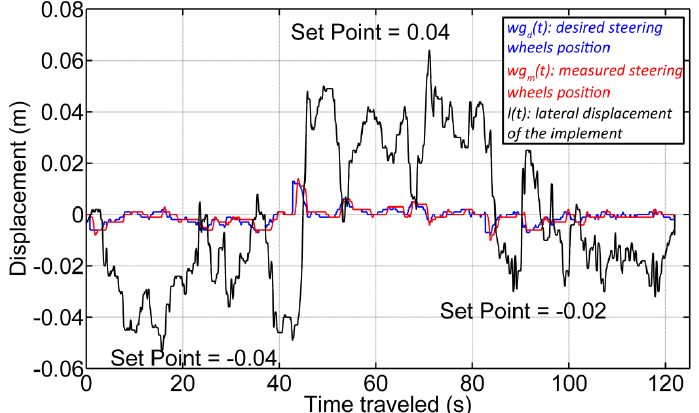
Figure 21. Experimental results of the implement lateral displacement control with three different